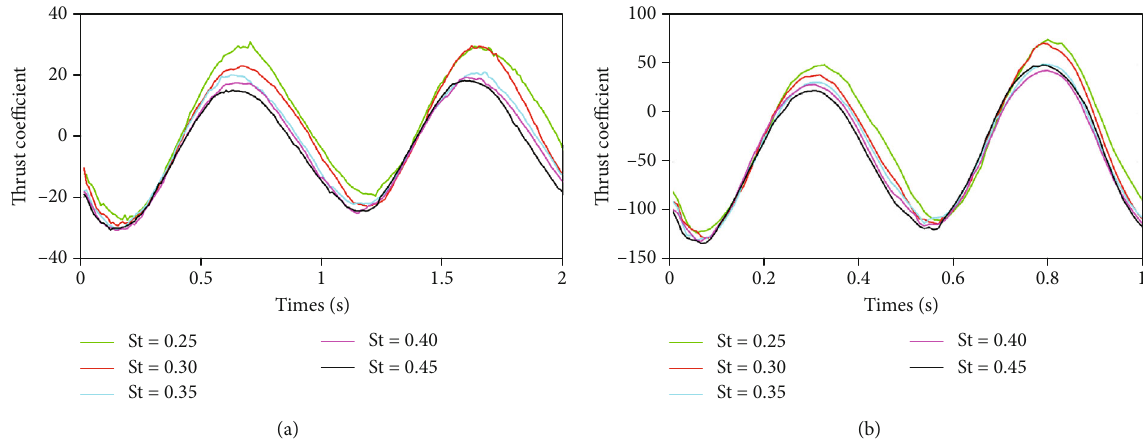
Figure 6: Forced condition of di ff erent values of St: (a) f = 0 : 5 Hz; (b) f = 1